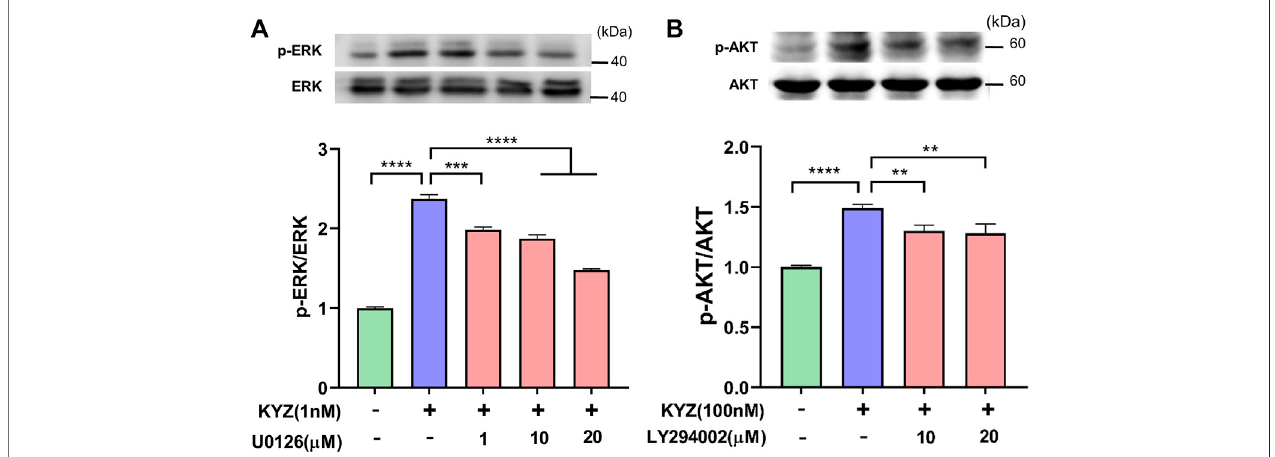
FIGURE 10 | Effect of PI3K inhibitor LY29402 and MEK1/2 inhibitor U0126 on the promoting angiogenesis activity of KYZ. (A) The HUVECs were pre-treated with PI3K inhibitor LY294002 and MEK1/2inhibitor U0126 for30 min, following byKYZ treatmentfor 24 h. (B) the gray value ofp-Akt and p-ERK were calculated byImageJ software and expressed as mean ± SEM, ** p < 0.01,*** p < 0.001,**** p < 0.0001 vs. control.